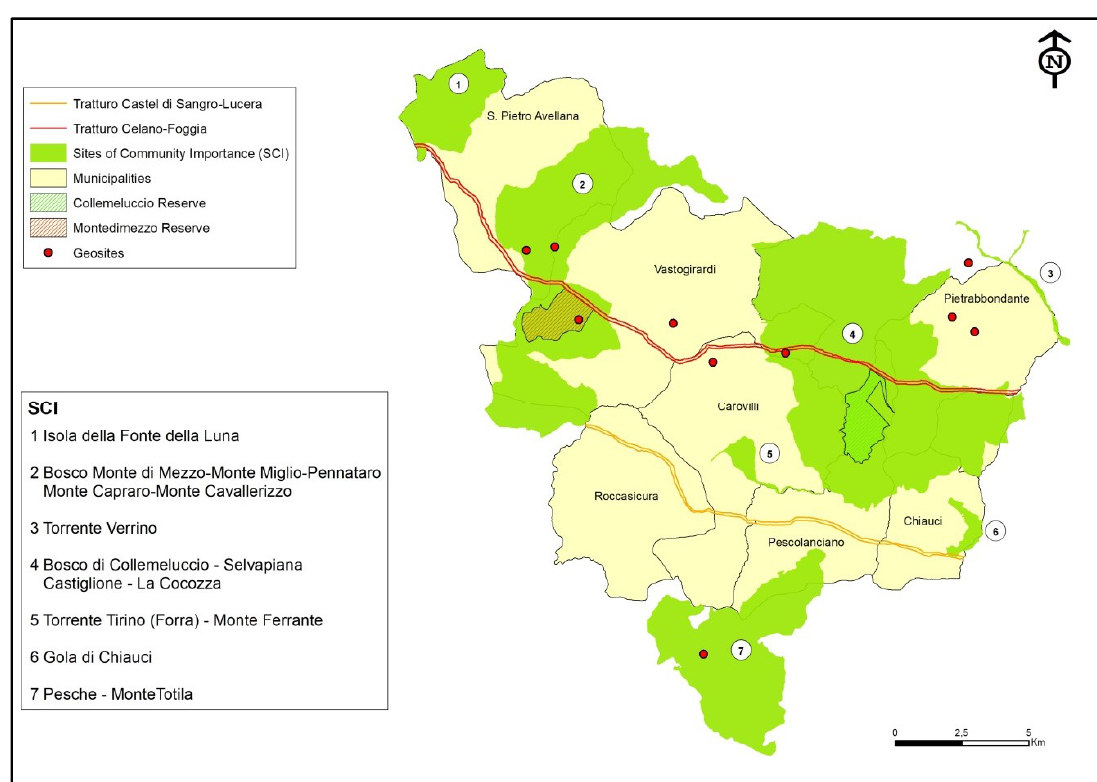
Figure. 3. The natural capital of the MaB area. Figure 3. The natural capital of the MaB